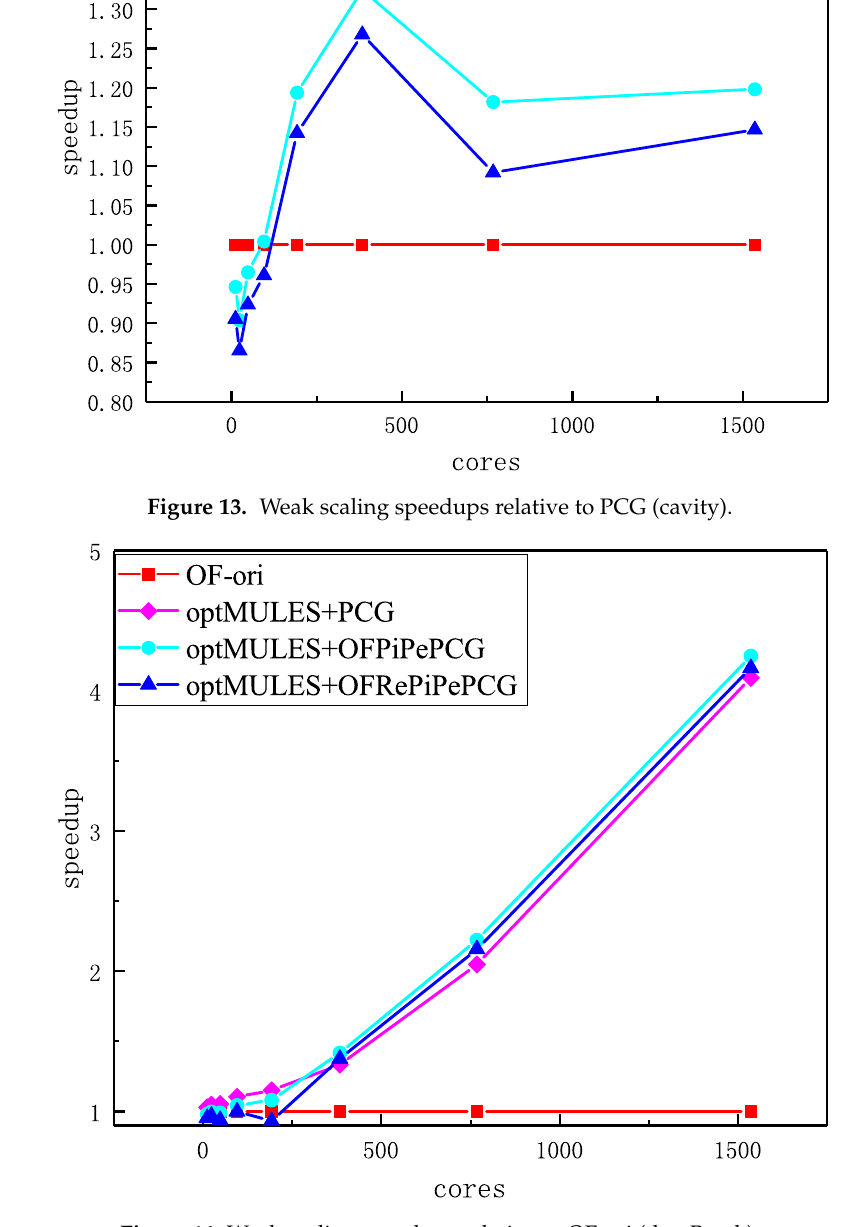
Figure 14. Weak scaling speedups relative to OF-ori